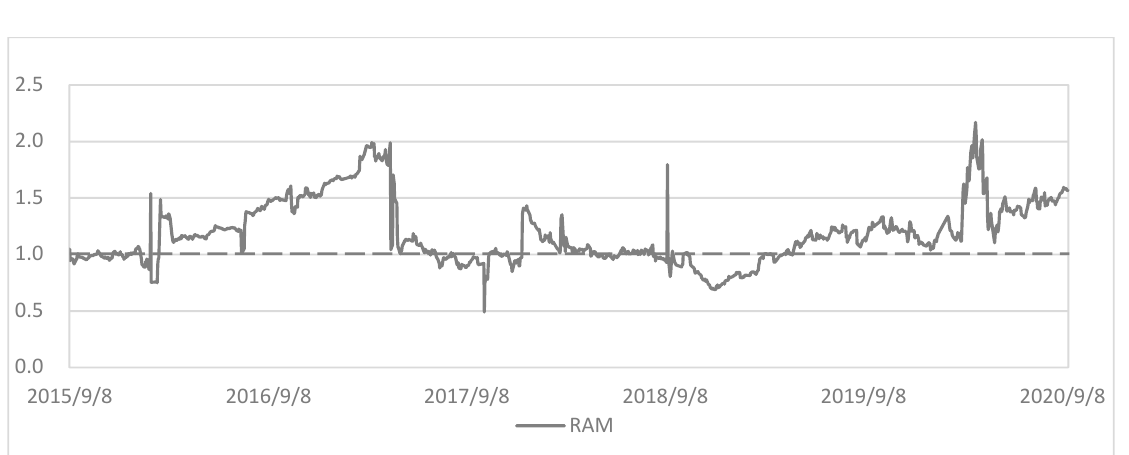
Energies 2021 , 14 , x FOR PEER REVIEW Figure 7. Asymmetry coefficient with rolling windows. Figure 7. Asymmetry coefficient with rolling windows.